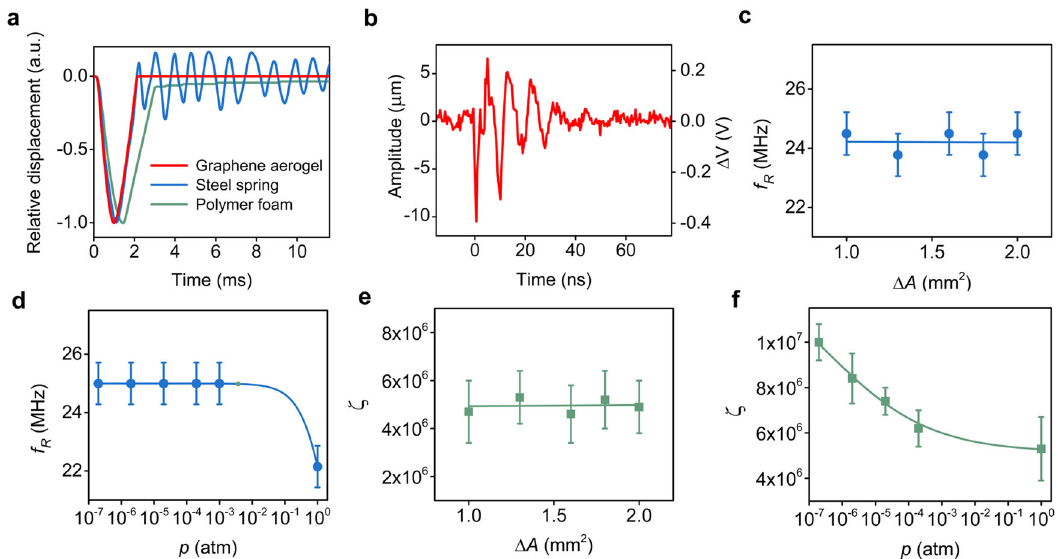
Fig. 4 Dynamic mechanical response of graphene aerogels. a Comparison of mechanical responses of elastic, plastic materials with graphene aerogel on the impact of a bouncing ball. b The natural resonance of a graphene aerogel block of the size of 2 mm × 1 mm × 2 mm on the mechanical impact. The amplitude was determined from the voltage response of the sample at a constant current of 100 mA. c , d Resonant frequency of graphene aerogel blocks as a function of the cross-section area at a constant sample thickness of 2 mm ( c ) and pressure ( d ). e , f Damping ratio dependence on the cross-section area ( e ) and pressure ( f ). Error bars represent the standard deviation in the measurements of ten different